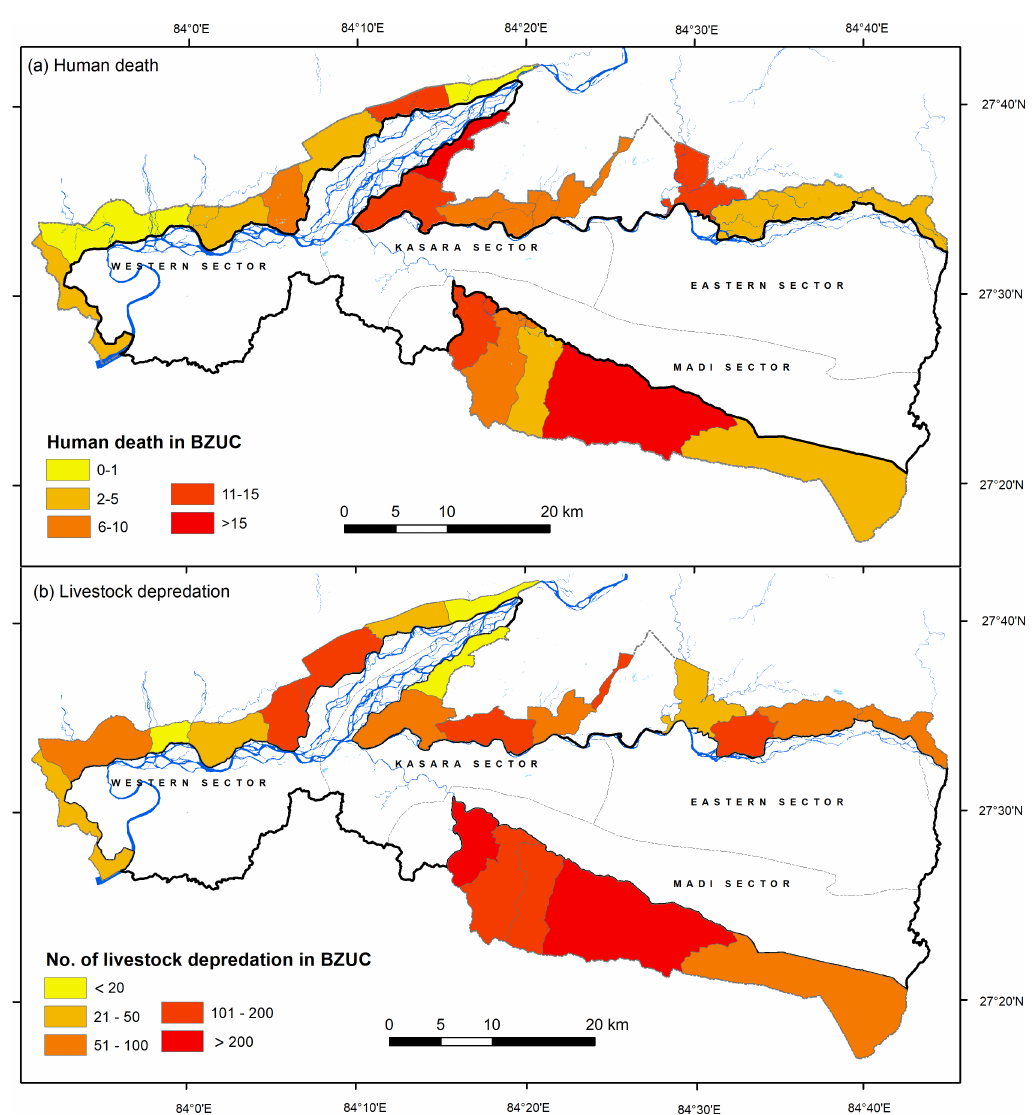
Fig 5. Spatial distribution of a) human killing and b) livestock depredation in buffer zone of Chitwan National Park,